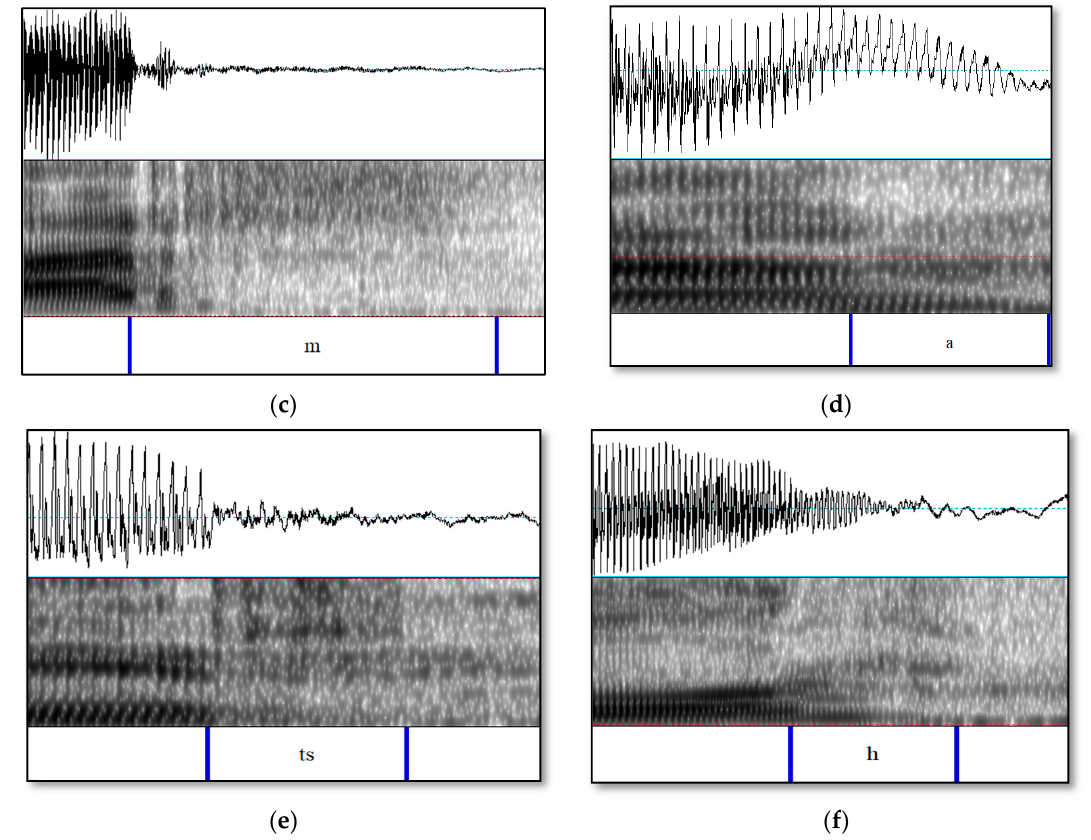
Figure 2. ( a ) Trill (t) in the word dador (donor). Male speaker UT086; ( b ) tap (r) in the word sopor (sleepiness). Female speaker UT079; ( c ) partially assibilated (m) rhotic in the word besar (to kiss). Female speaker UT079; ( d ) approximant ( a ) in the word to weigh (pesar). Male speaker UT080; ( e ) assibilated trill (ts) in the word beber (to drink). Male speaker UT085; ( f ) aspirated rhotic (h) in the word tutor (tutor). Female speaker UT105.